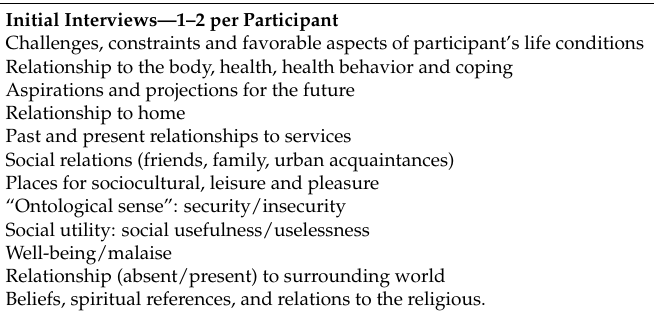
Table 2. Domains of inquiry on homelessness and mental